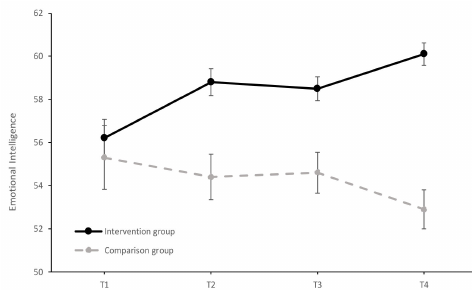
Figure 1. Evolution of the average EI scores ( ± SEM) in the intervention and comparison groups over time (T1 = baseline; T2 = at the end of the first year of intervention; T3 = follow-up after the first year of intervention; T4 = at the end of the second year of intervention).